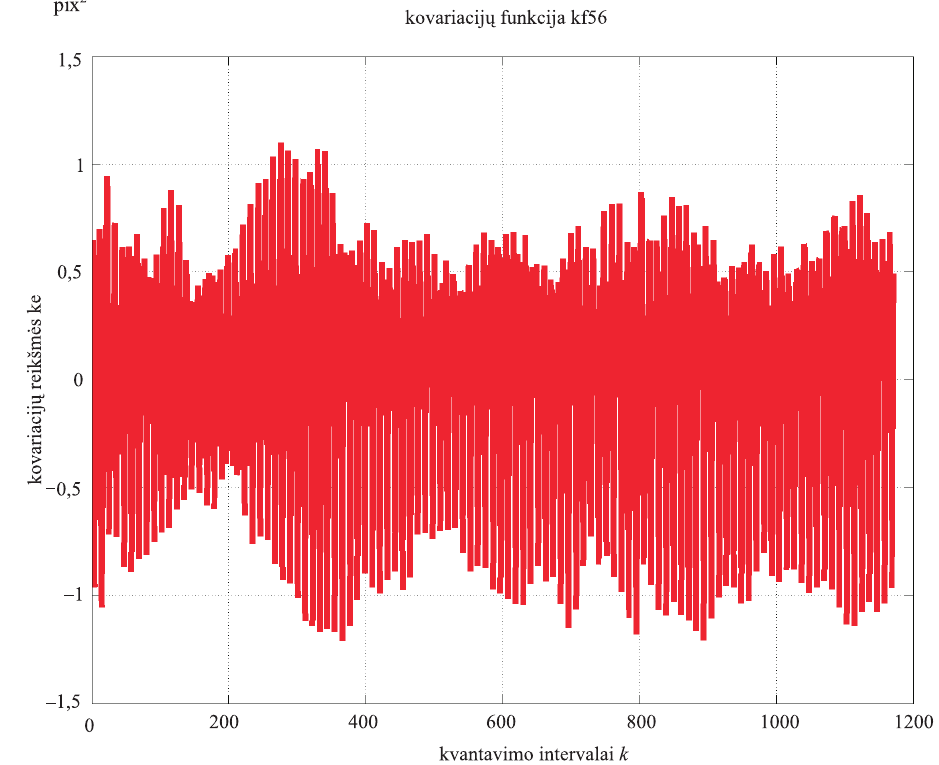
Fig. 4. Graphic view of the covariance function of the two scales by the moving quantation